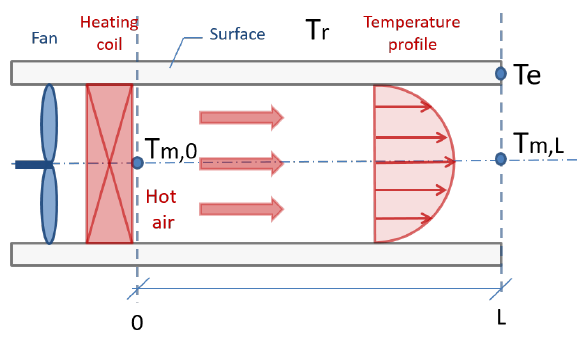
Figure 2: Internal heat flow profile